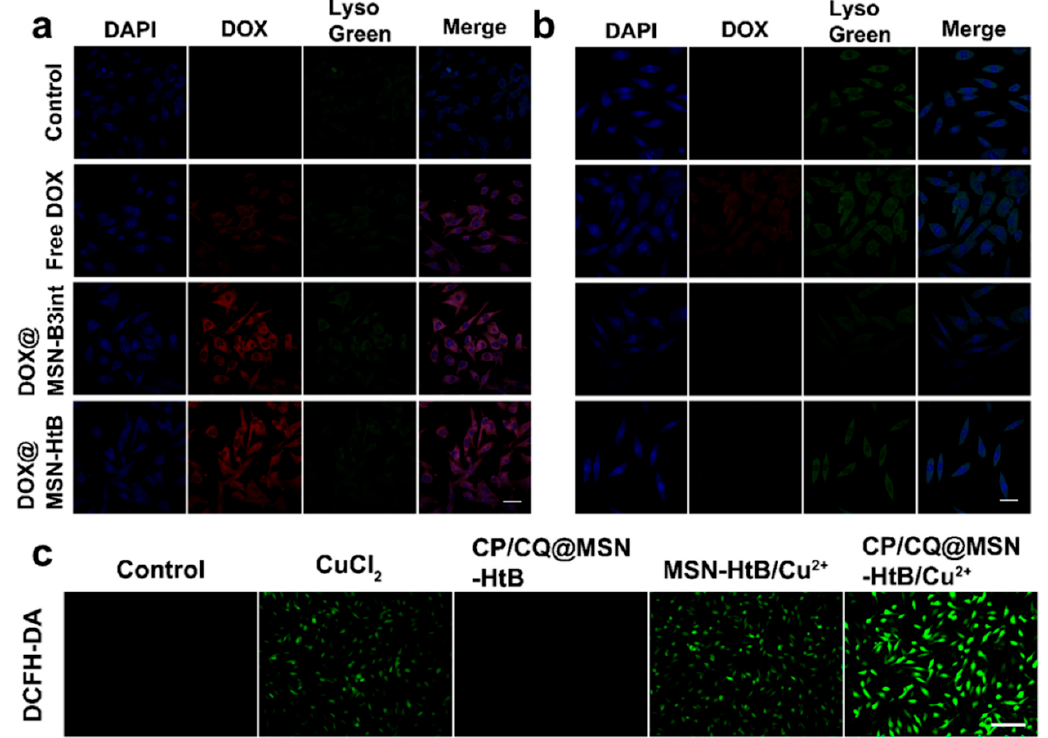
Figure 3. CLSM images of ( a ) B16 and ( b ) L-929 cells treated with DOX, DOX@MSN − B3int, and DOX@MSN − HtB. Scale bars: 25 μ m. ( c ) Fluorescence images of B16 cells co-stained with DCFH-DA after different treatments. Scale bar: 25 μ m.